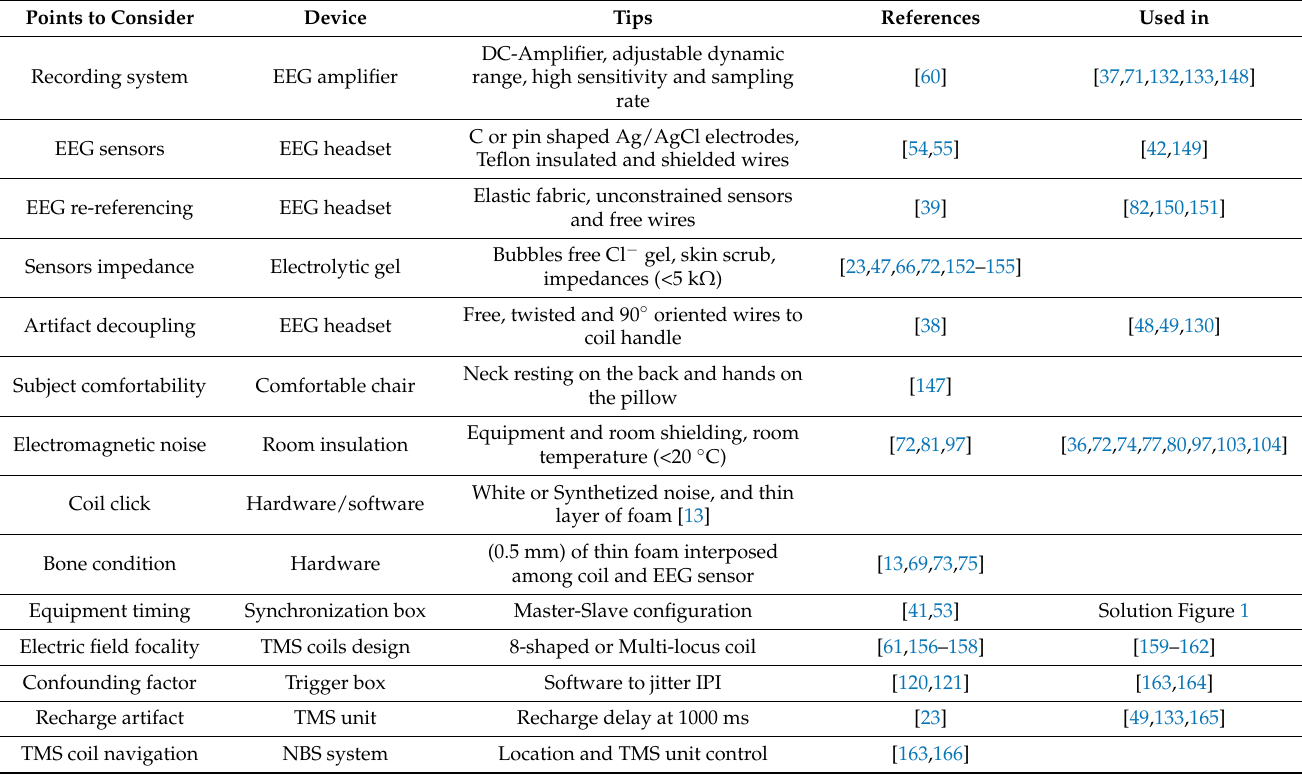
Table 3. Special kinds of artifacts evoked by TMS: Strategies for online